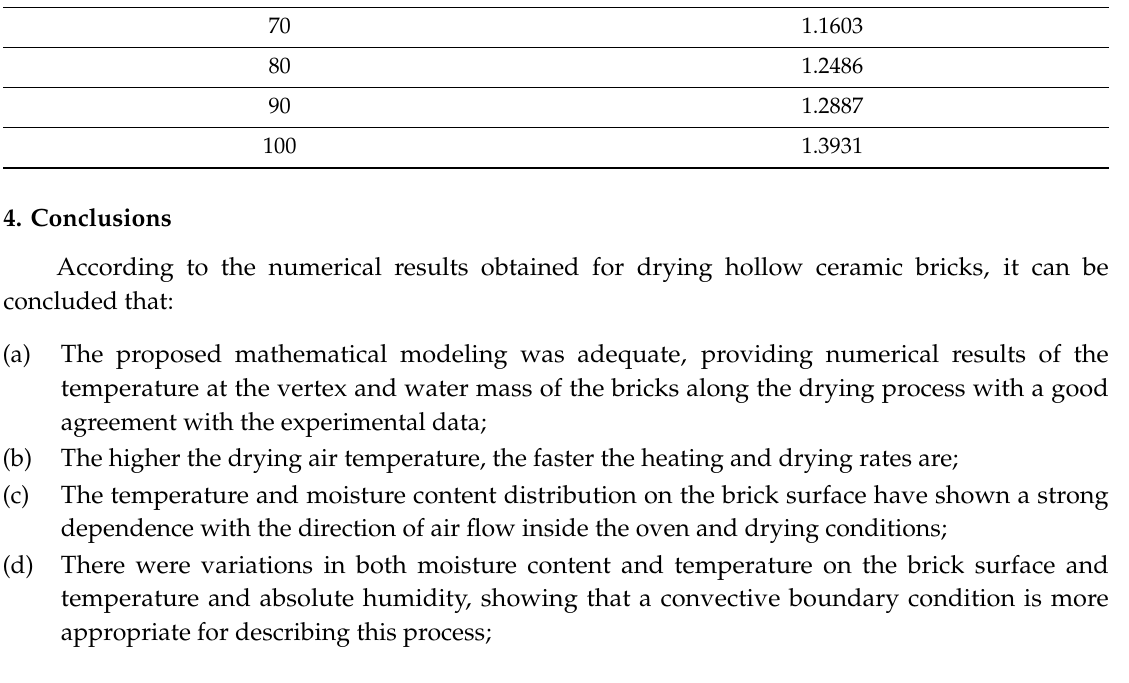
Table 4. Convective heat transfer coefficient obtained with the simulations.